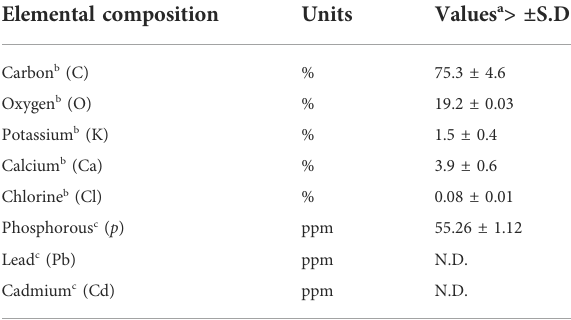
TABLE 3 Elemental composition of Cannabis sativa biochar. Elemental composition Units Values a > ±S.D.